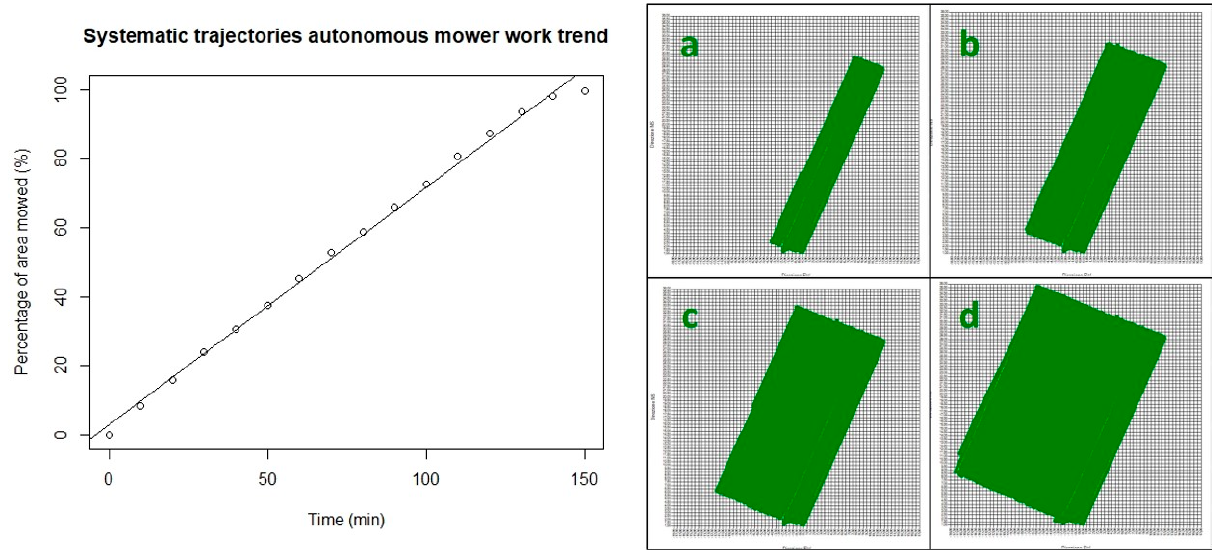
Figure 1. ( Left ) Data trend of mowed area percentage as a function of time (min) for the autonomous mower with systematic trajectories working on 600 m 2 : observed values averaged across 4 replications (dots) and regression line (solid line). ( Right ) Custom-built software showing the mowed area on 27 July 2020 at different time intervals: ( a ) 30 min; ( b ) 60 min; ( c ) 90 min; ( d ) 150 min.